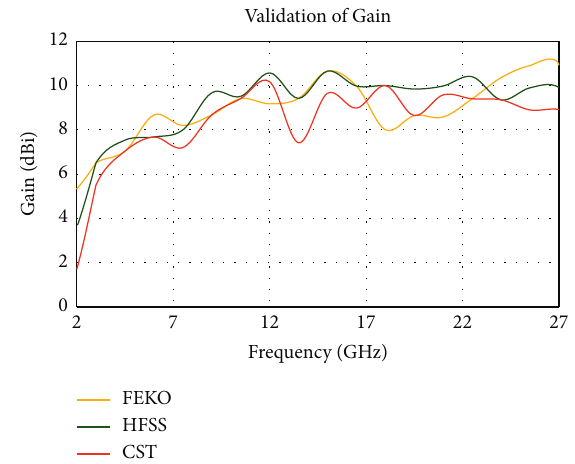
Figure 10: Validation of gain curve of the proposed Vivaldi antenna.